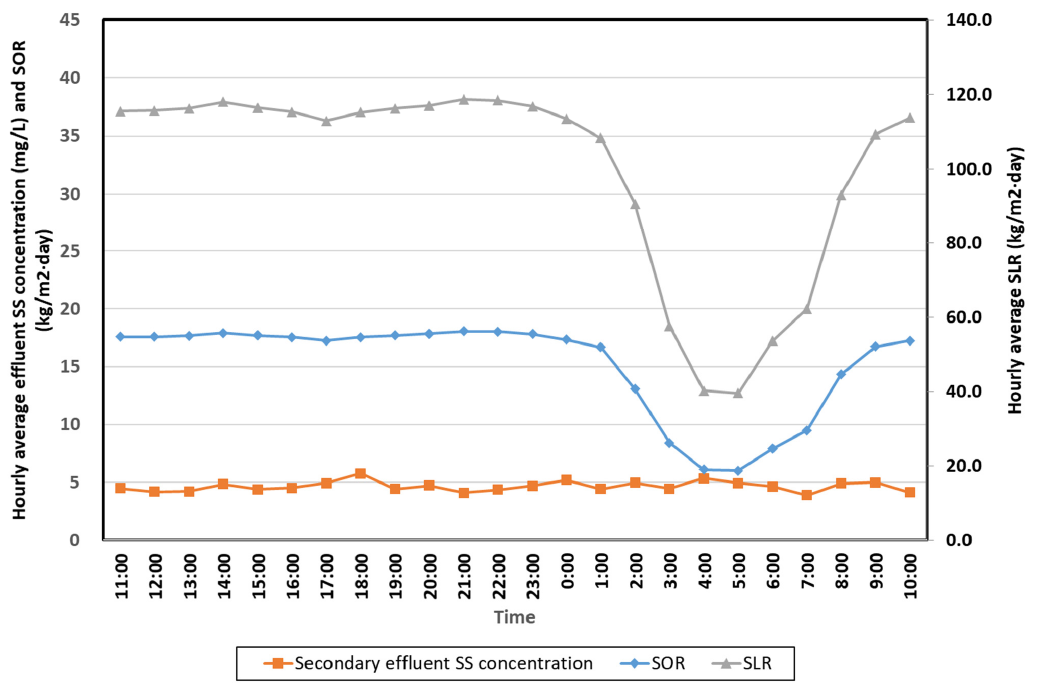
Figure 6. Average hourly effluent SS concentration along with average hourly SOR and SLR at the secondary clarifier at plant B.